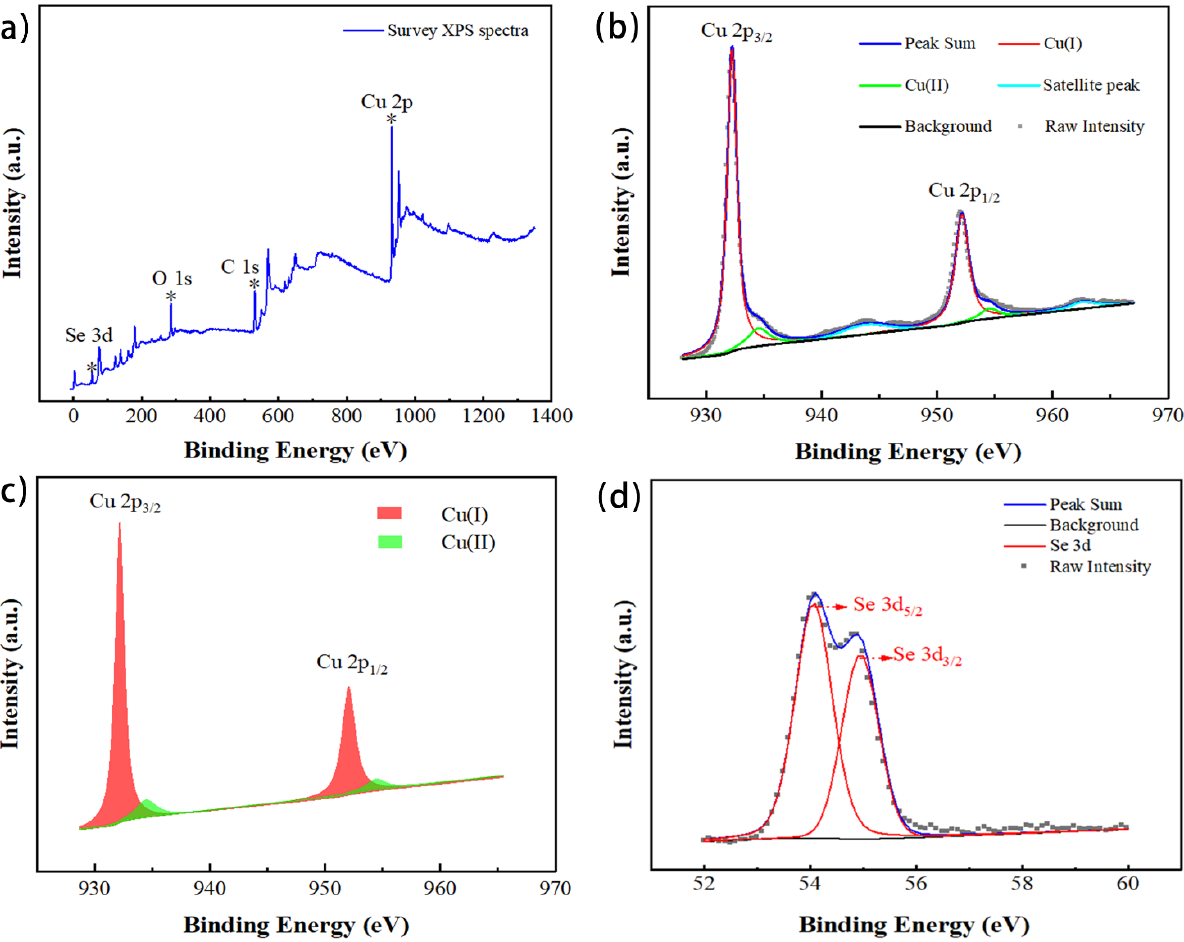
Figure 4. X-ray photoelectron spectroscopy (XPS) analysis of the Cu 2 Se thin film. ( a ) Survey. ( b ) Cu 2p. ( c ) Cu(I):Cu(II). ( d ) Se 3d.